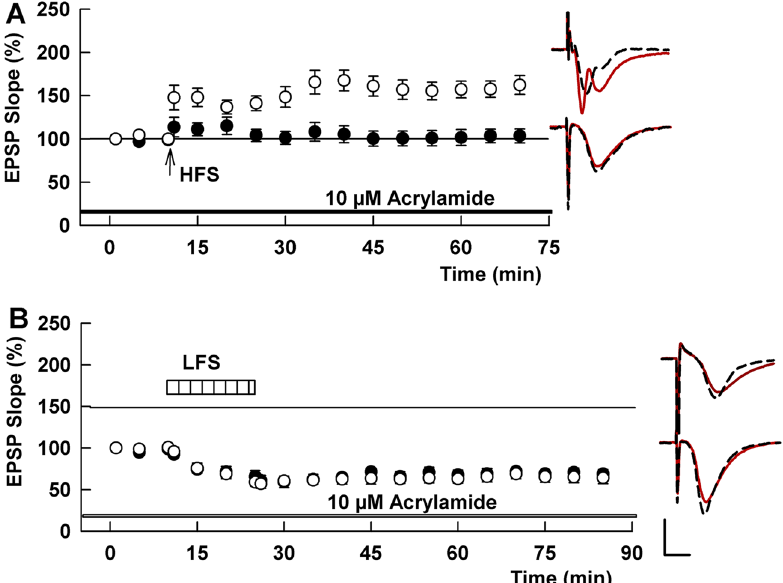
Figure 2. ACR inhibits LTP, but not LTD, in the CA1 region of rat hippocampal slices. ( A ) Ten μM ACR when administered for 4 h or more prior to and during slice recording (black bar) blocks LTP induction (black circles) after a single 100 Hz × 1 s HFS (arrow). Control LTP in naive hippocampal slices is shown in white circles. Traces to the right of this graph and in subsequent figures show representative EPSPs at baseline before HFS (dashed traces) and 60 min following HFS (solid red lines). Calibration bar (Panel B): 1 mV, 5 ms. ( B ) Ten μM ACR (black bar) does not inhibit LTD induction after LFS (hatched bar). Control LTD is shown in white circles. Traces show representative EPSPs at baseline before LFS (dashed traces) and 60 min following LFS (solid red